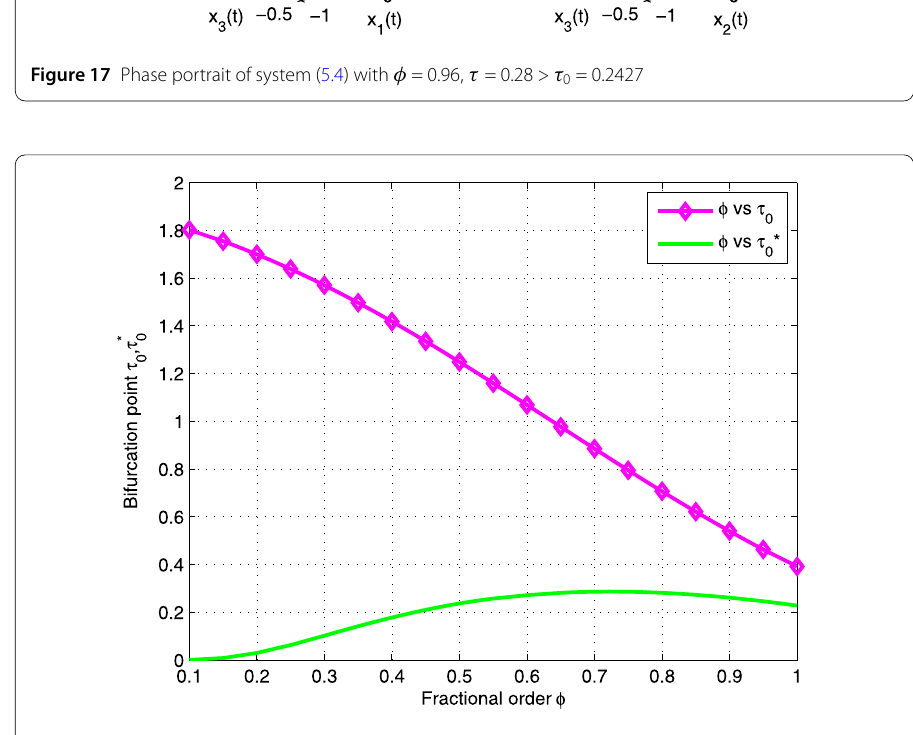
Figure 18 Effects of φ on τ 0 in system (5.3) and τ ∗ 0 of system